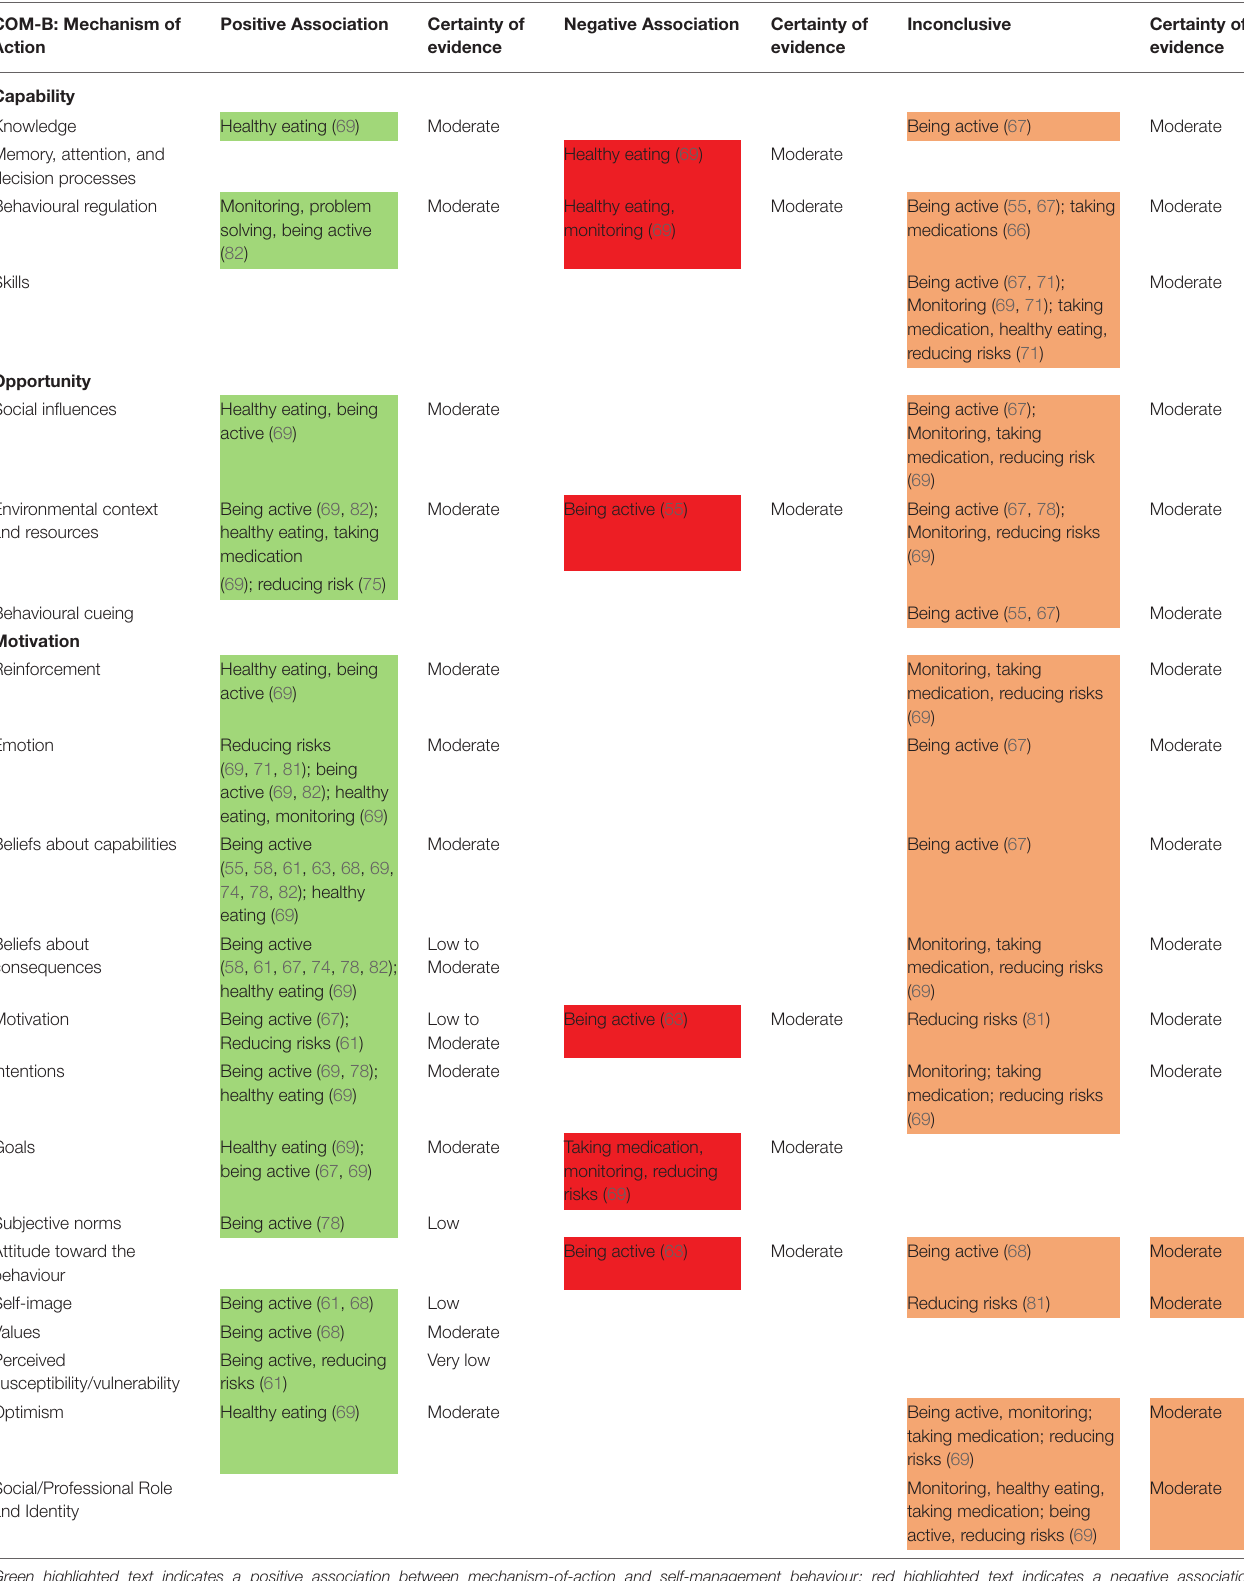
Green highlighted text indicates a positive association between mechanism-of-action and self-management behaviour; red highlighted text indicates a negative association between mechanism-of-action and self-management behaviour; and amber highlighted text indicates that the evidence was inconclusive to determine an association between a mechanism-of-action and a self-management